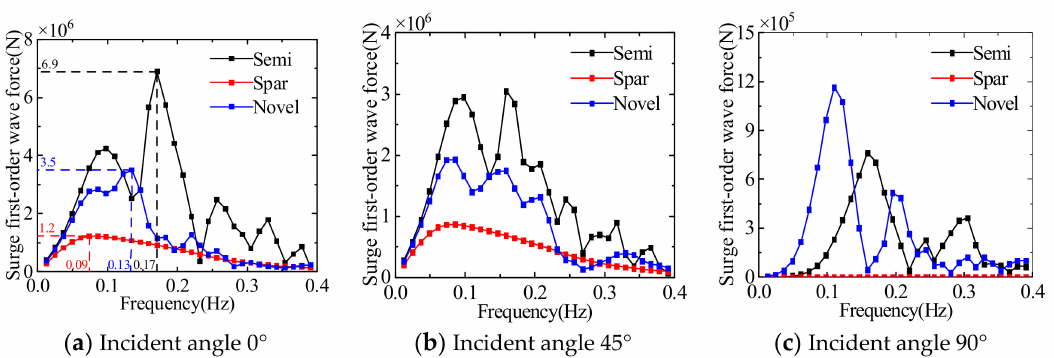
Figure 11. Comparison of the first-order wave force in surge direction of three floating platforms.